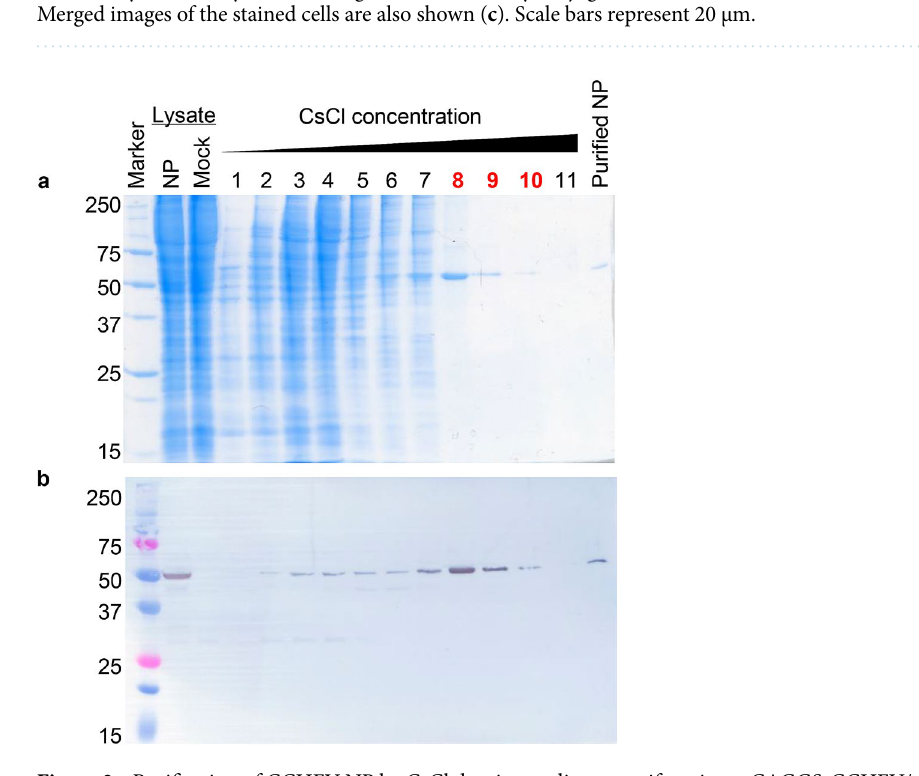
Figure 2. Purification of CCHFV NP by CsCl density gradient centrifugation. pCAGGS-CCHFV/ NP-transfected HEK293T cells were lysed and fractionated through CsCl density gradient centrifugation as descibed in Methods. Each fraction was analyzed by SDS-PAGE ( a ) and Western blotting ( b ). Crude lysates of pCAGGS-CCHFV/NP- and mock-transfected HEK293T cells and purified NP obtained from pooled fractions 8–10 are also